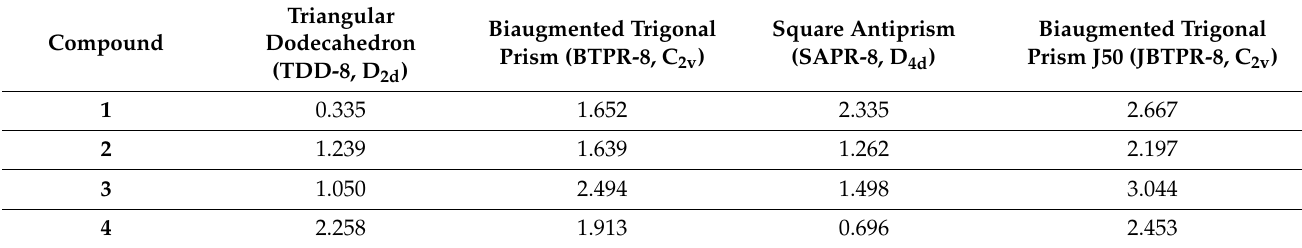
Table 3. Lowest values of the calculated continuous shape measurements (CShMs) for compounds 1 – 4